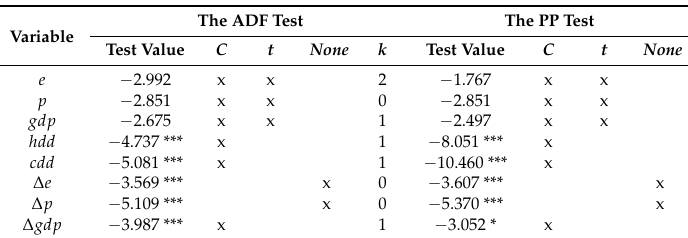
Table 3. The Unit Root test